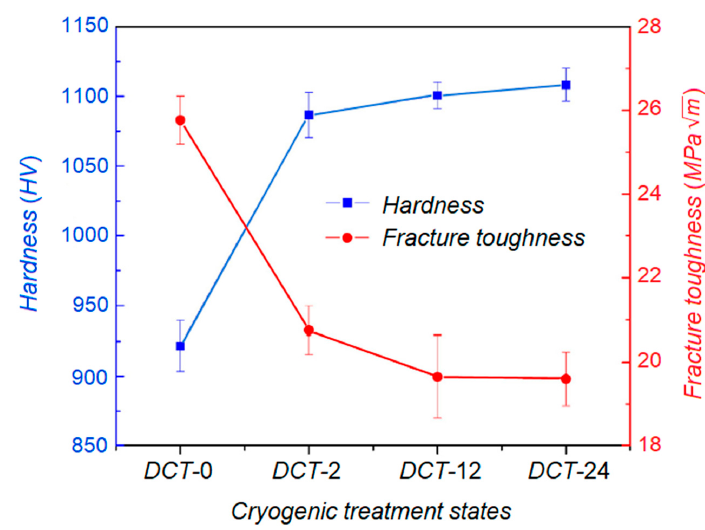
Figure 3. The hardness and fracture toughness of WC-Fe-Ni cemented carbides before and after DCT with different soaking time [38].